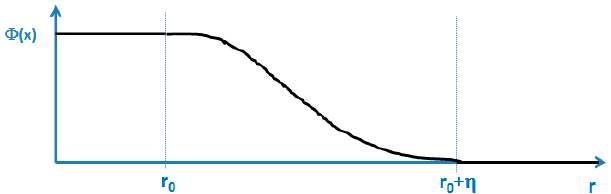
Figure 2. Scheme of the phase-field function Φ ( x ). This function takes the value 1 wherever the object/sphere is present and 0 else. In contrast to the Heaviside function it reveals a continuous transition over a finite—though very small—interface thickness η